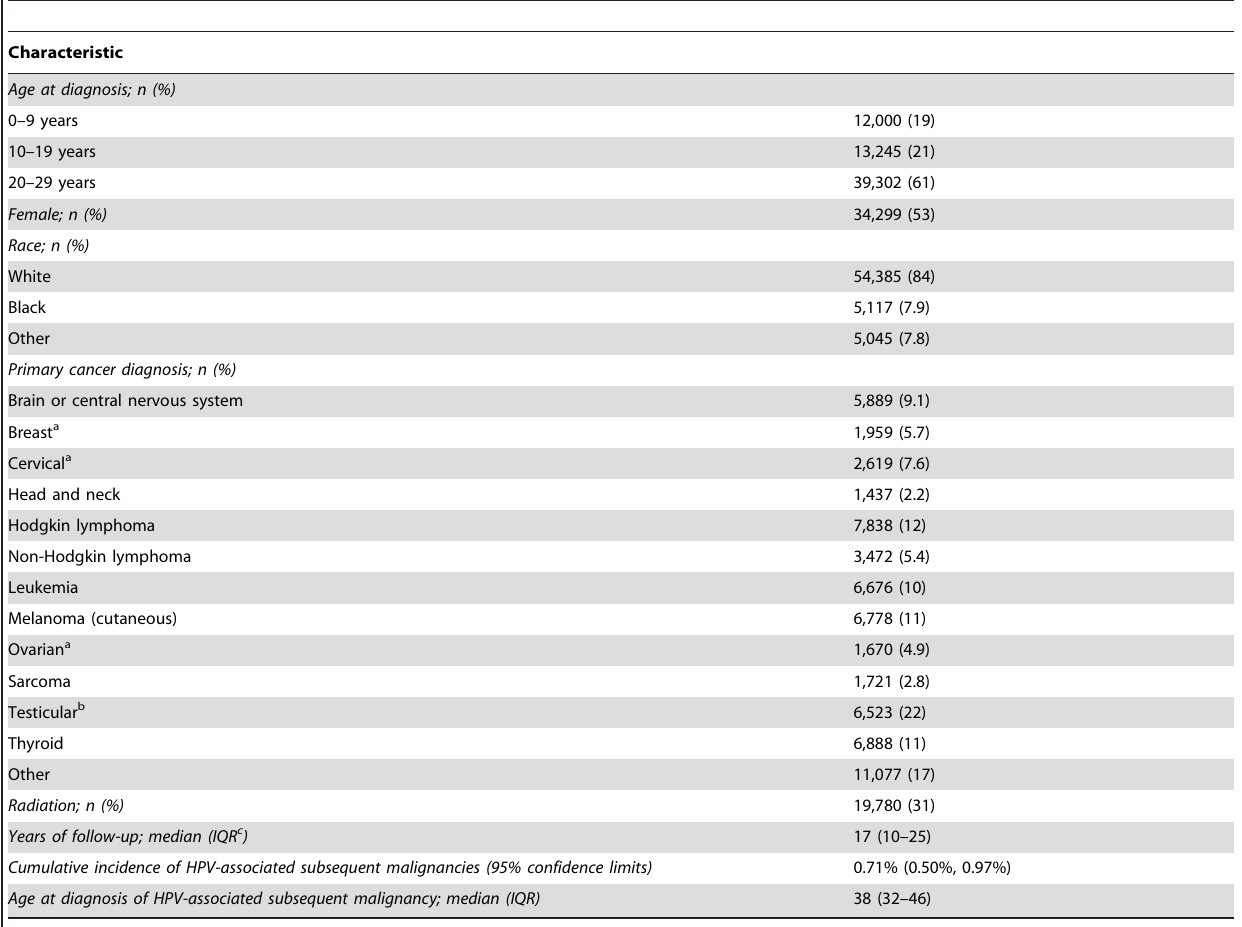
Table 1. Characteristics of pediatric and young adult (PAYA) cancer survivors diagnosed between 1973 and 2010 in the United